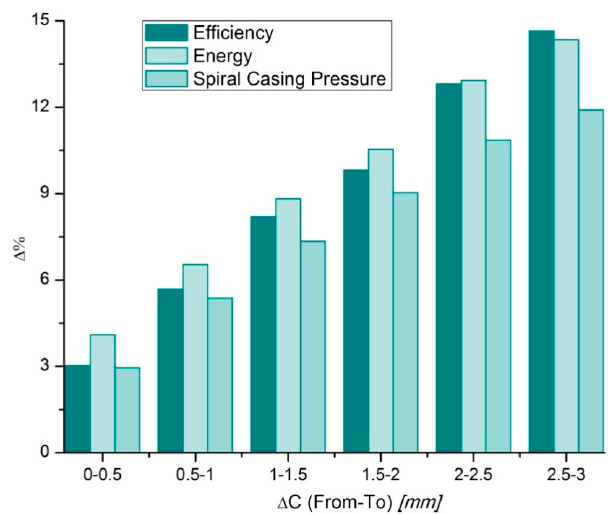
Figure 9. Variation in hydraulic performance with clearance gap. Δ : Percentage change in values.